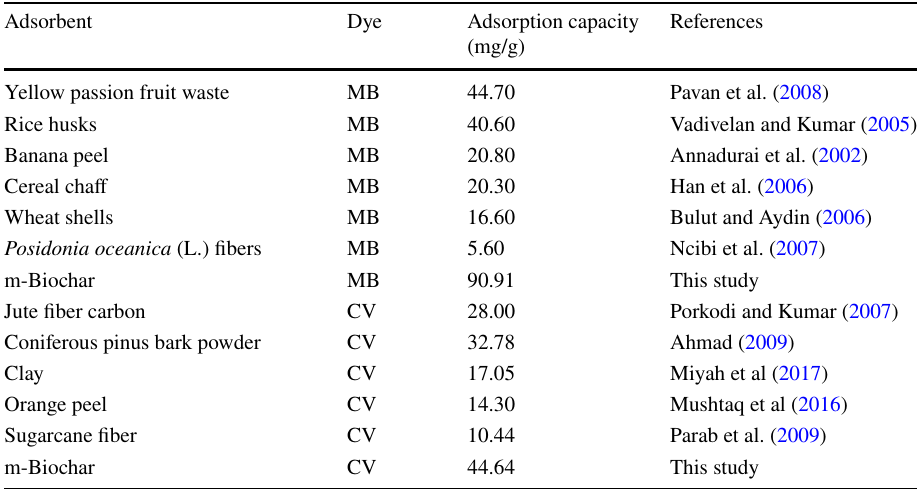
Table 3 Langmuir-based maximum adsorption capacity of several adsorbents for MB and CV dye